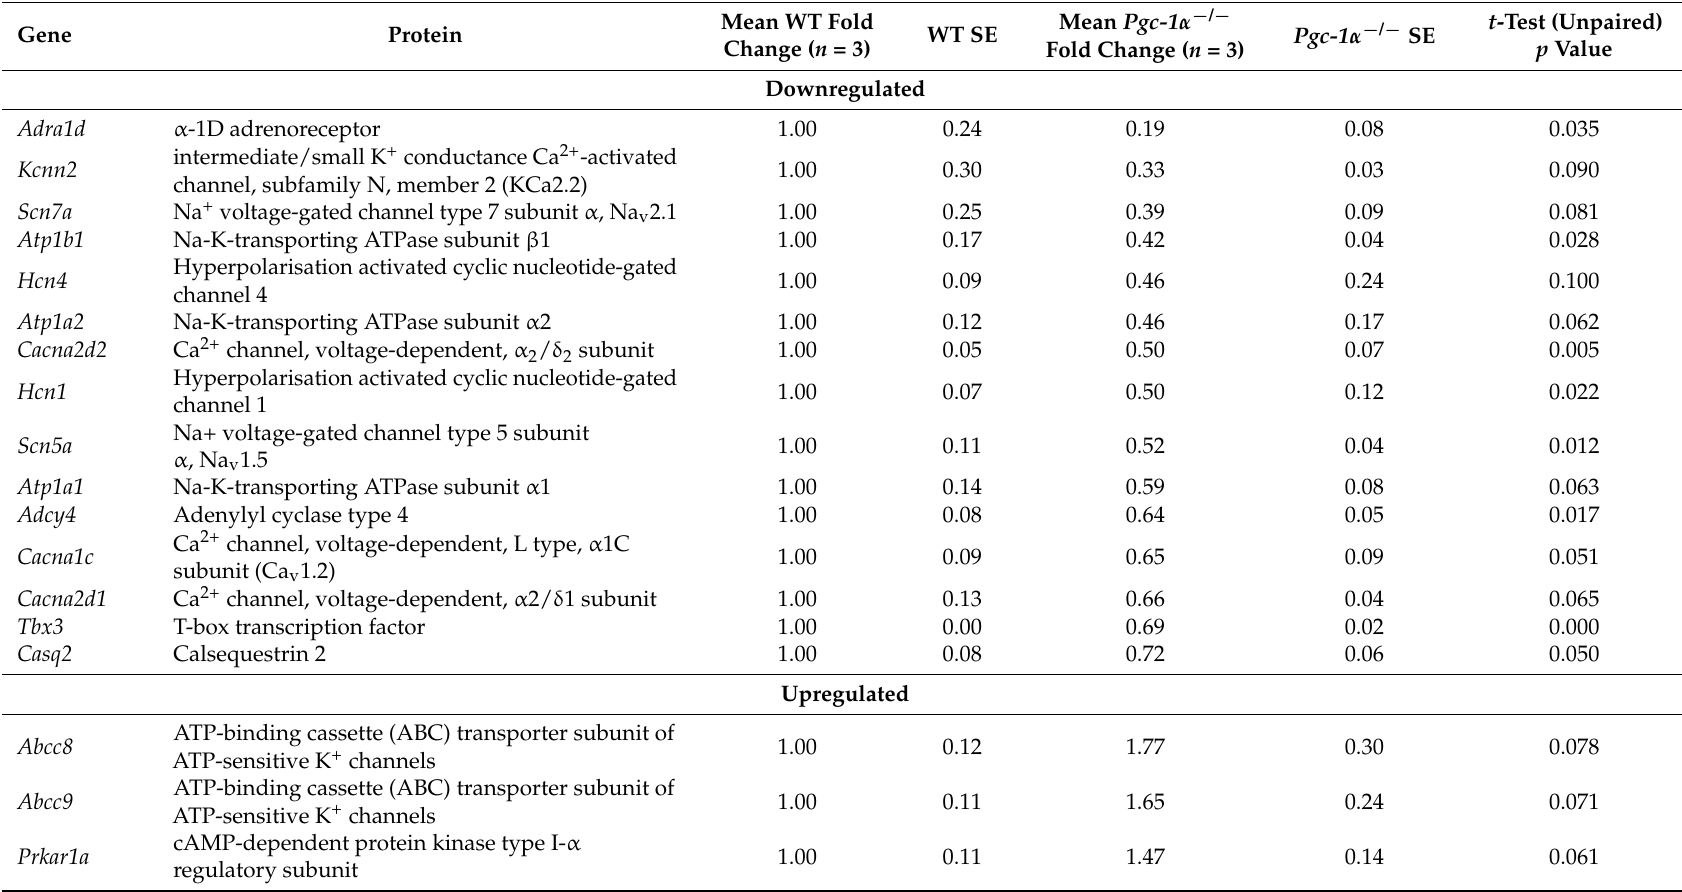
(B) Mean Gene Fold Changes in Pgc-1 α − / − Compared to WT Atria Ordered by Size of Fold Change for Changes with p ≤